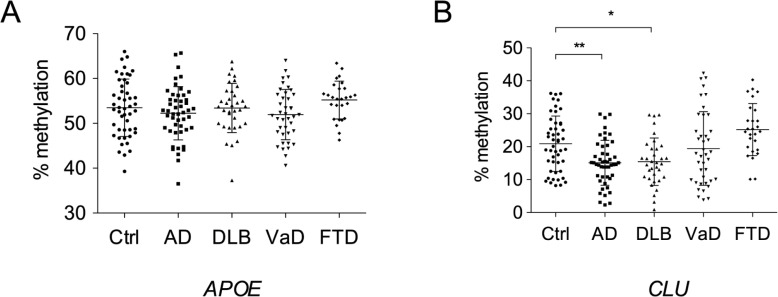
Methylation rates at CpG island shores of APOE and CLU in non-AD dementia.Methylation rates at the CpG island shores of APOE and CLU in DLB, VaD, and FTD were quantified by Sanger sequencing, and differences relative to control subjects in the test group were assessed using one-way ANOVA with Dunnett’s multiple comparison post-test. The positions of the CpG island shores examined were the same as those in Fig 2. Abbreviations: Ctrl, control; AD, Alzheimer’s disease; DLB, dementia with Lewy bodies; VaD, vascular dementia; FTD, frontotemporal dementia.